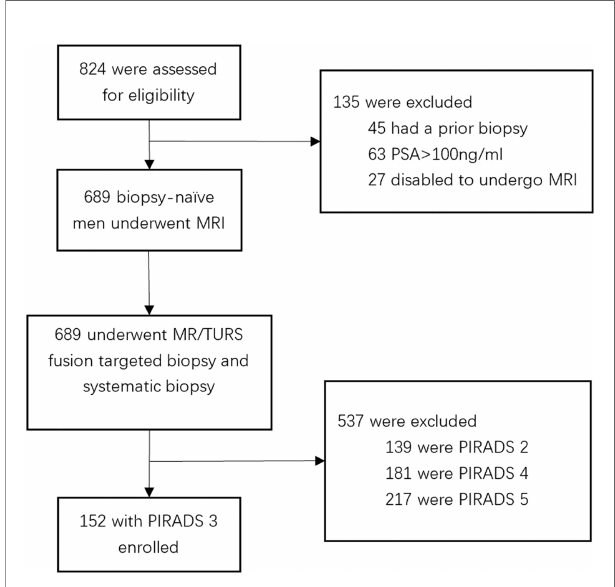
FIGURE 1 | Flowchart for study inclusion among biopsy-naïve men with PIRADS 3 with clinical suspicion for prostate